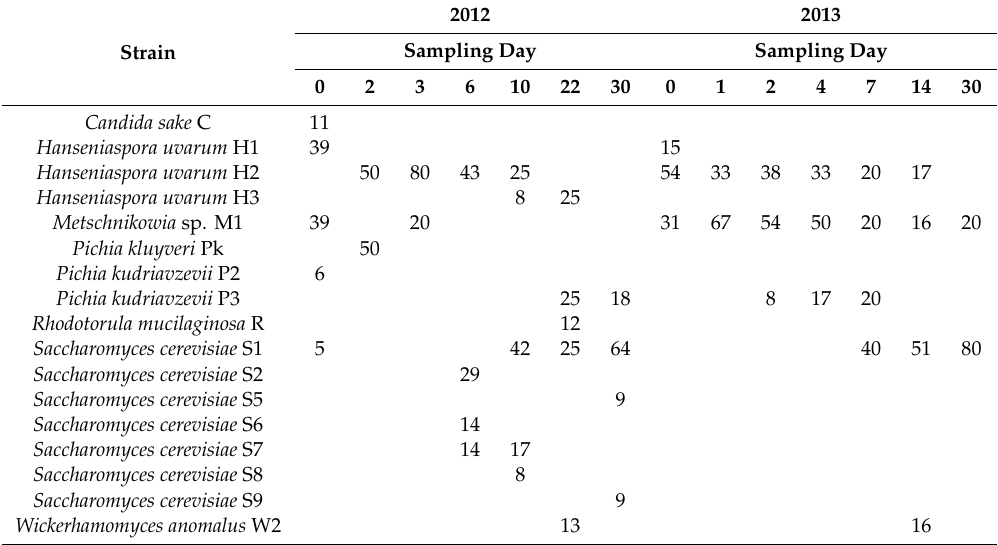
Table 3. Yeast strains (%) isolated from di ff erent stages of ˇCaˇcanska Lepotica plum mash fermentation (2012 and 2013